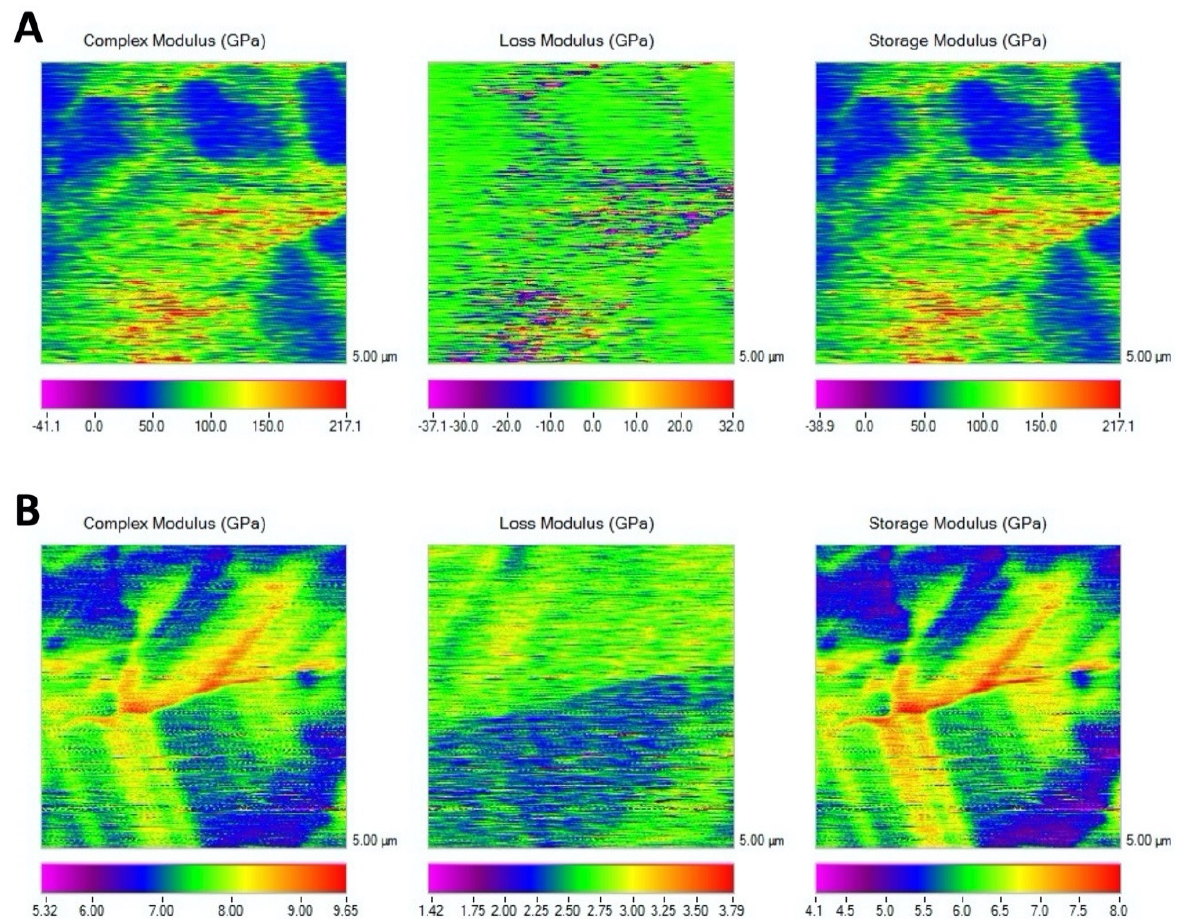
Figure 2. Nano-DMA mapping of the three membranes after 21 d of SBFS immersion. ( A ) Derma and ( B ) Evolution. Scale bars are in GPa. Scan size is 5 µm × 5 µm.